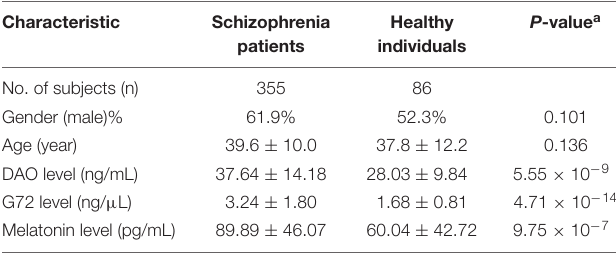
TABLE 1 | Demographic characteristics of schizophrenia patients and healthy